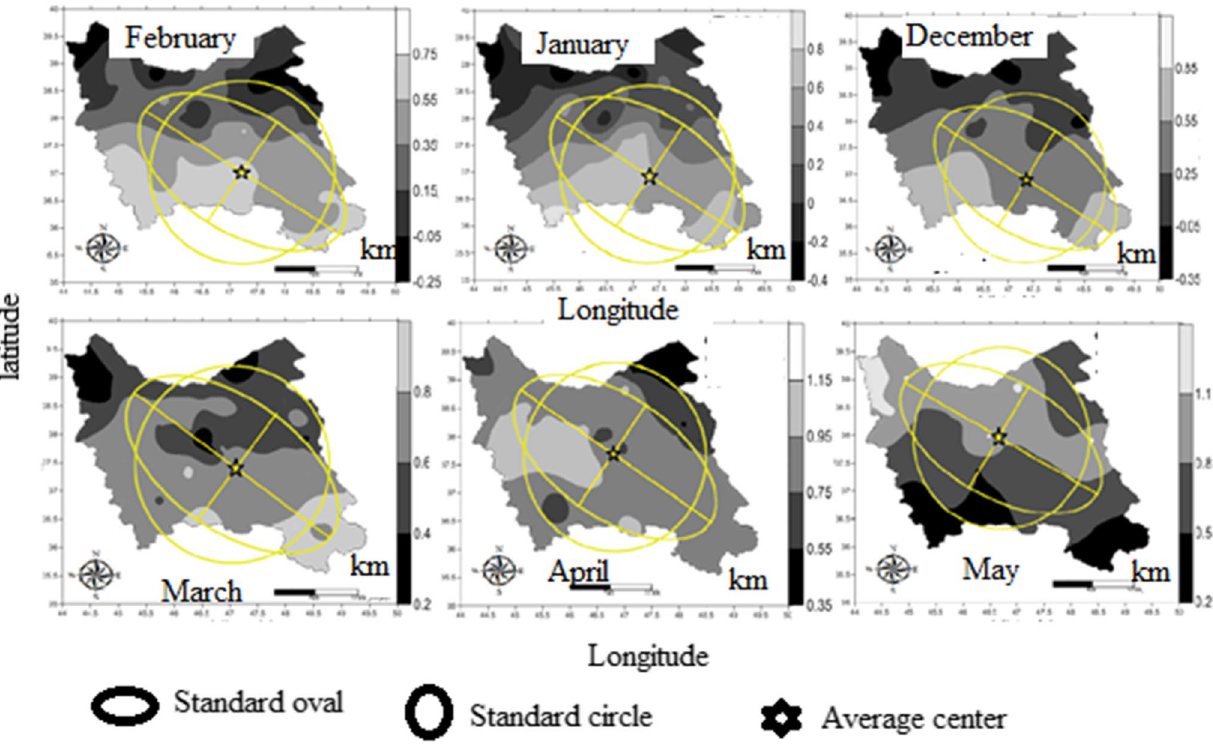
Fig. 4 Spatial distribution of monthly values SPI of winter and spring seasons and their distribution and central indices in northwest of Iran SPI. Source :